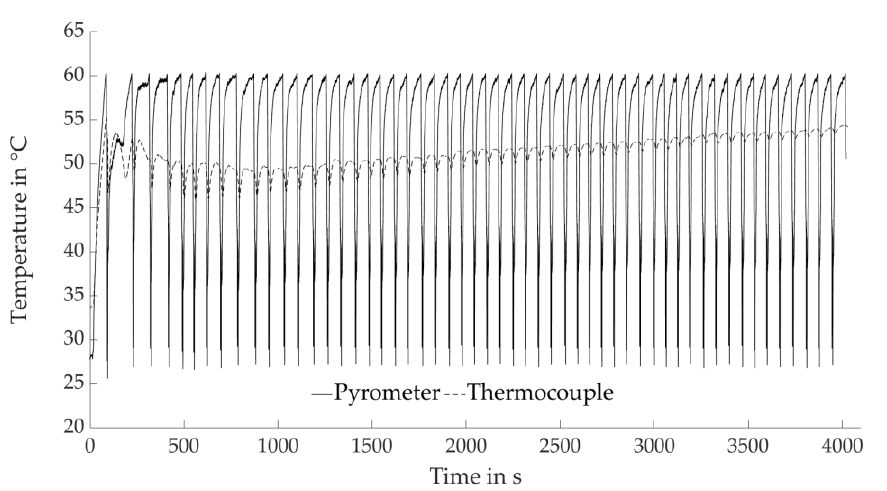
Figure 5. Exemplary in-process temperature profile (50;1;3.4). Comparison of the pyrometer signal at an emissivity of 1 (digital values) and the temperatures measured by thermocouple.